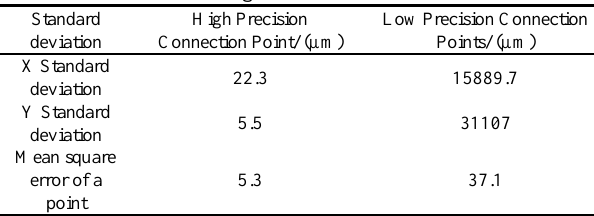
Table 2. Comparison of accuracy of different connection points extraction